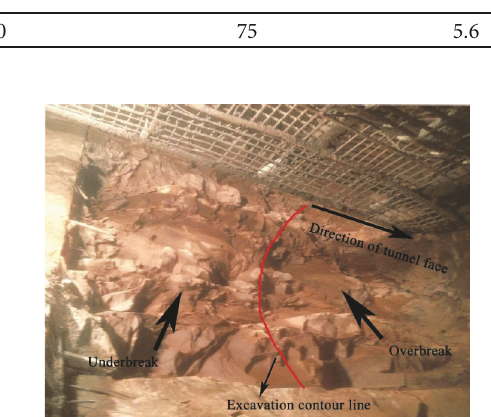
Figure 1: A typical working face with overbreak and underbreak after two-step